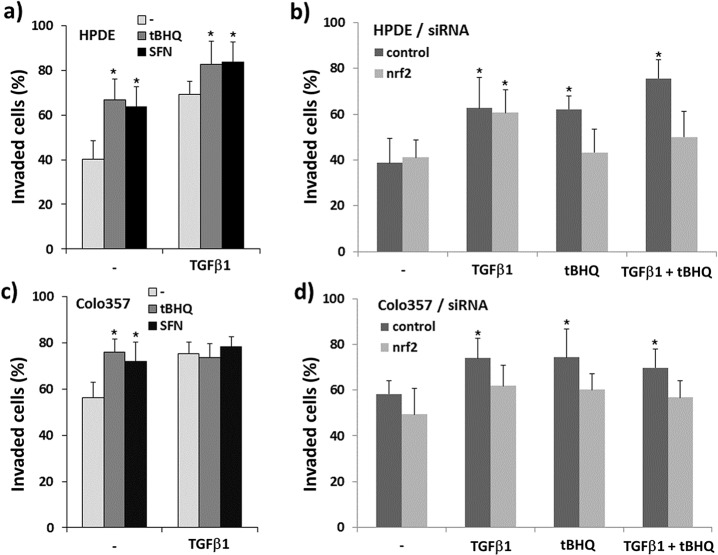
Effect of Nrf2 activation and TGF-β1 on the invasiveness of premalignant HPDE and malignant Colo357 pancreatic duct cells.Modified Boyden chamber assays on collagen-I coated transwells were performed with A) HPDE or C) Colo357 cells treated either alone or in combination with 50 μM tBHQ, 10 μM SFN or 10 ng/mL TGF-β1, or left untreated for 24h. Data are expressed as percentage of invaded cells and represent the mean ± SD from eight independent experiments, *p<0.05 (+tBHQ and +SFN versus–tBHQ and–SFN, respectively). Boyden assays were also conducted with B) HPDE cells or D) Colo357 cells subject to Nrf2 or control siRNA treatment for 48h (westernblot verification shown in Figs. A and B in S2 File) prior to further treatments with 50 μM tBHQ and/or 10 ng/mL TGF-β1. Data are expressed as percentage of invaded cells and represent the mean ± SD from six independent experiments, *p<0.05 (treated versus untreated).